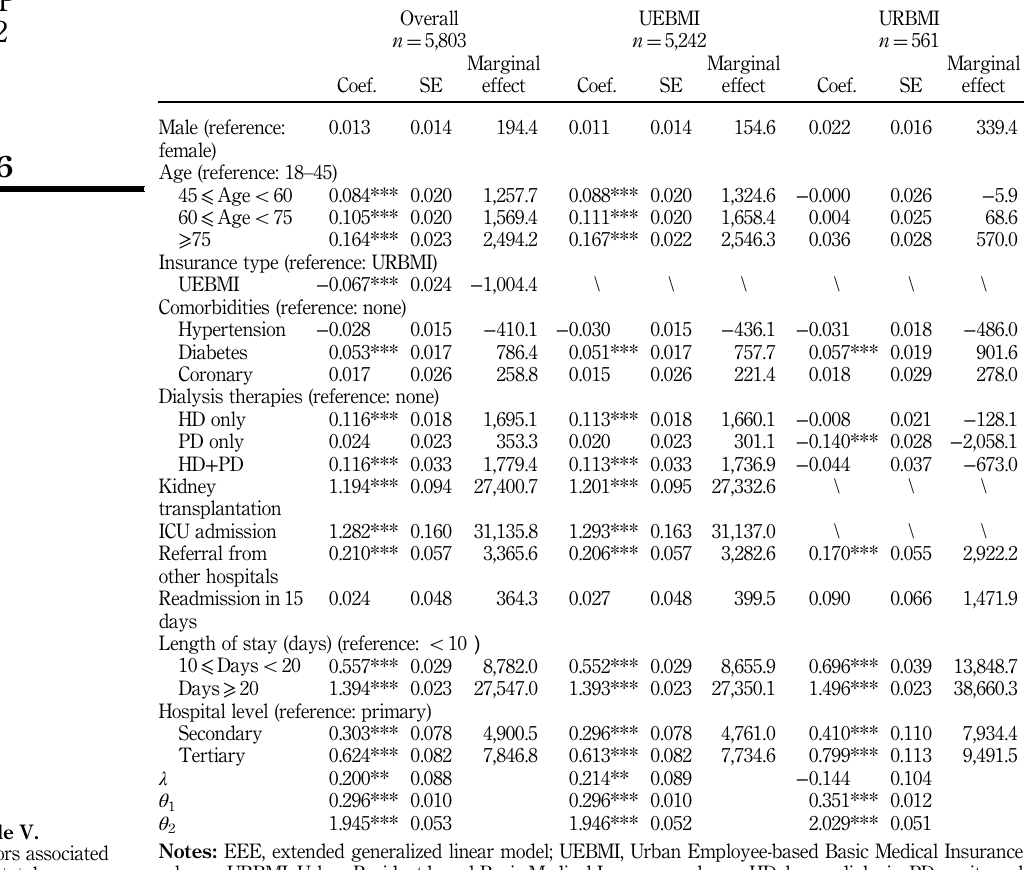
Table V. Factors